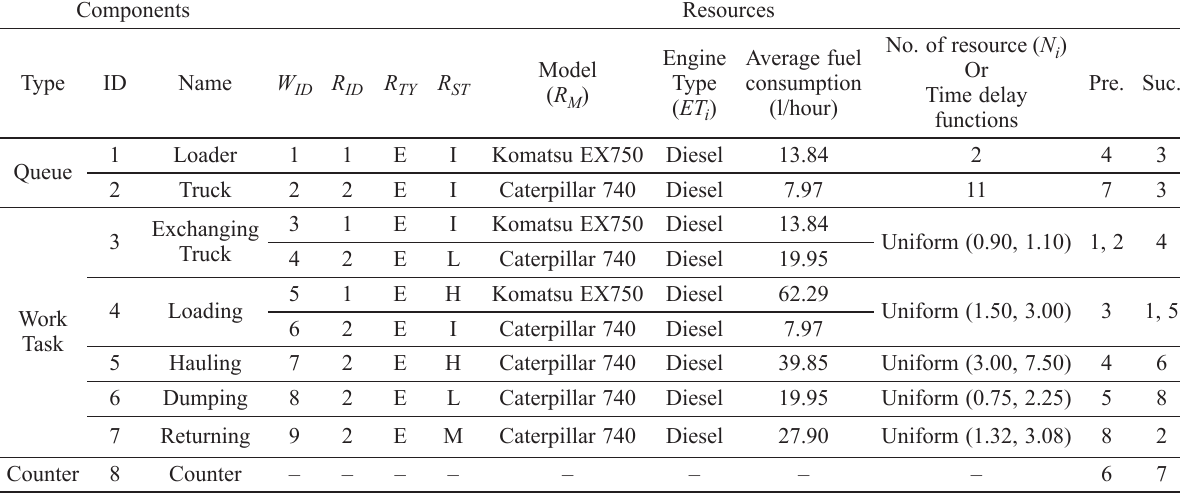
Table 5. Resource matrix defining the resource entities and work tasks for test case 2